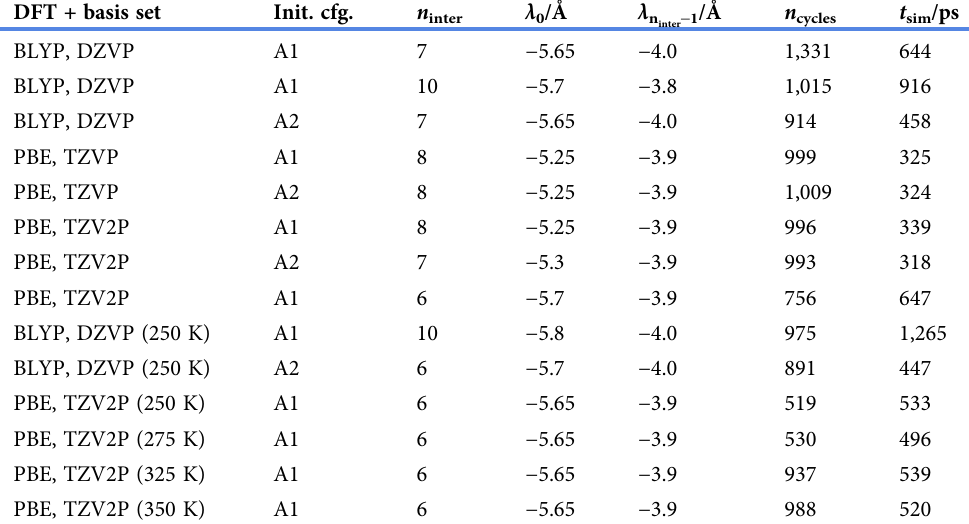
Table 2 Summary of all RETIS simulations. Column 1 shows the combination of the DFT method and basis set used in this particular simulation, with the initial con fi guration (see Fig. 1) shown in column 2. Column 3 shows n inter , the total number of interfaces used, while columns 4 and 5 show the positions chosen for the fi rst interface, λ 0 , and the fi nal interface, Column 6 shows n cycles , the total number of RETIS cycles, where one cycle consists of one RETIS move (time reversal, swapping or shooting) and subsequent path generation in each RETIS ensemble. Column 7 shows the total simulation time t sim . DFT + basis set Init.